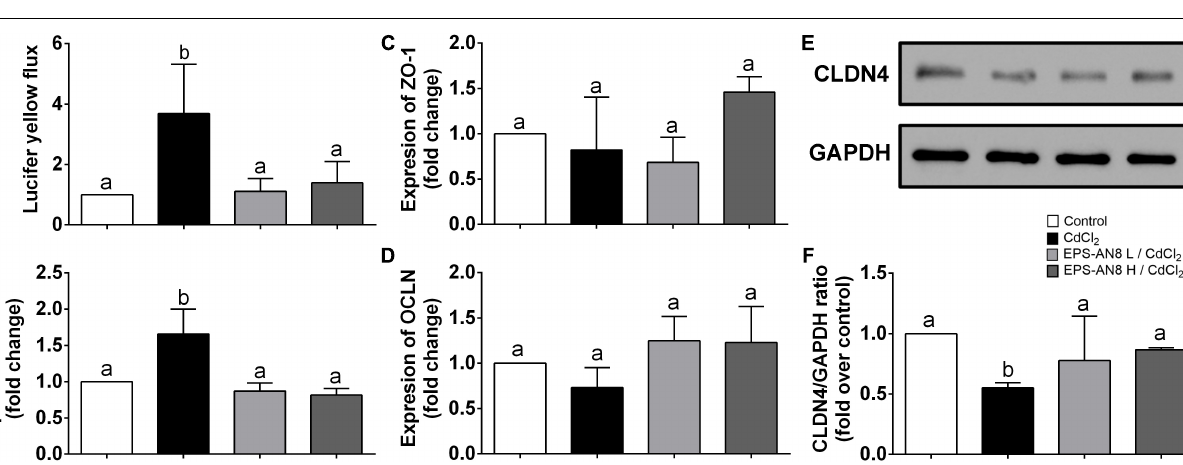
FIGURE 4 | Protection from Cd-induced disruption of cell junctions by EPS-AN8. (A) Rate of passive transport of Lucifer yellow through Caco-2 cell monolayer after Cd exposure and coexposure with Cd and EPS-AN8 (L and H). (B) Effect on mRNA of adherence junction protein CDH1 after 3 h. Effect on mRNA of tight junction proteins ZO-1 (C) and OCLN (D) after 3 h. (E,F) Effect on expression of CLDN4 protein and representative Western blot and densitometric analysis after 24 h of incubation, respectively. Values that do not share a common letter are significantly ( p < 0.05)